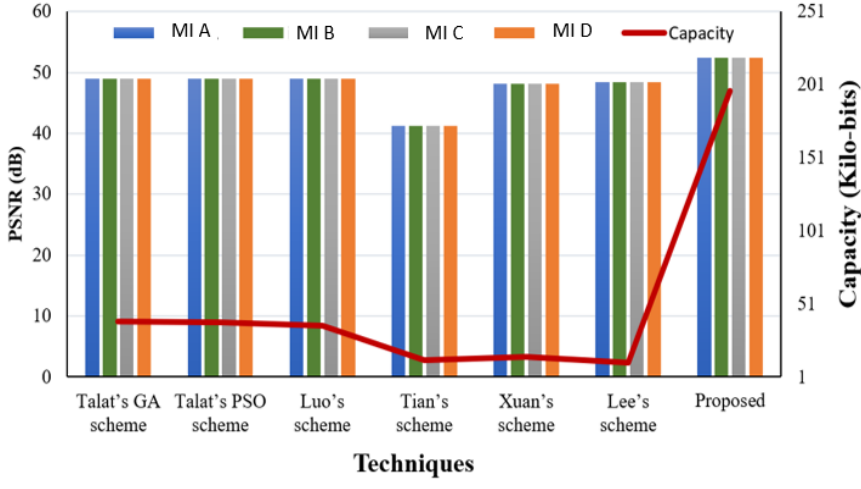
Figure 6. Perceptual transparency comparison.